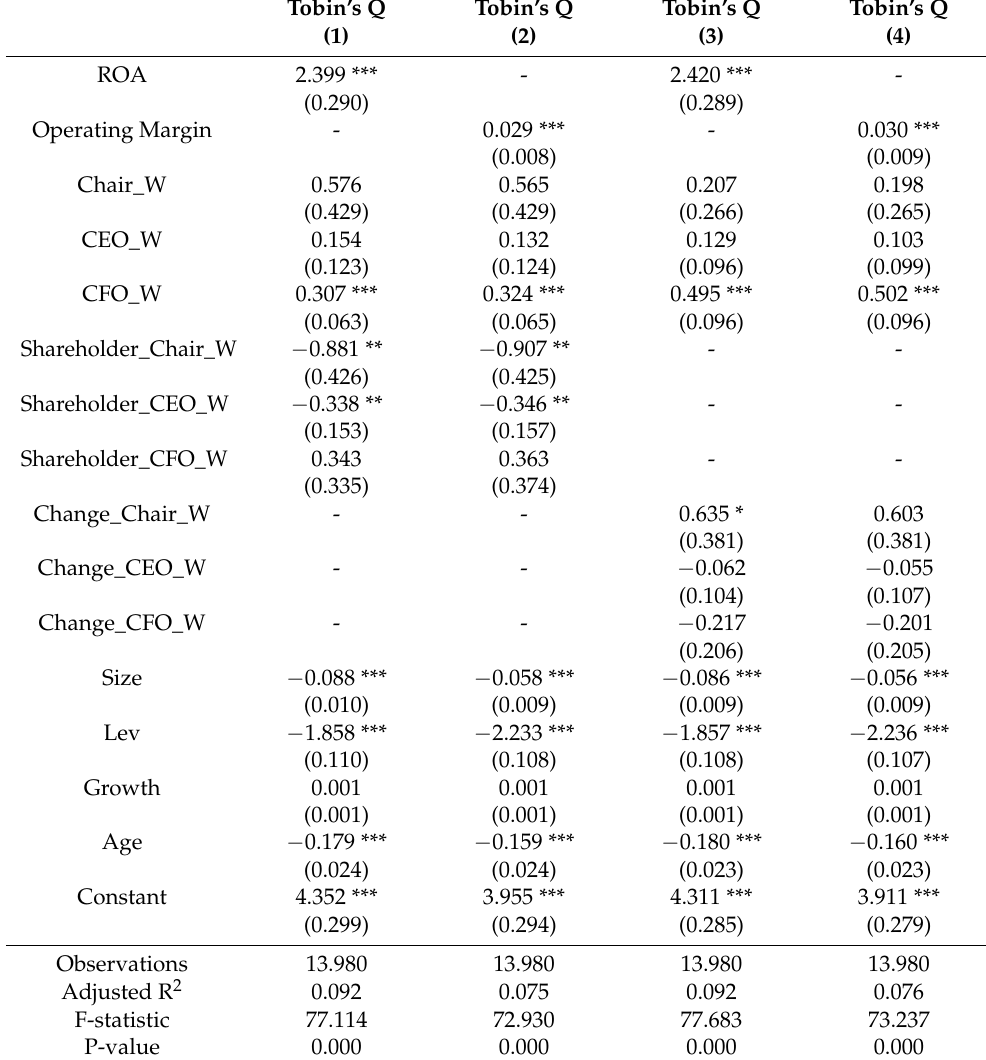
Table 6. Role of being a shareholder and gender change in Chair, CEO, and CFO